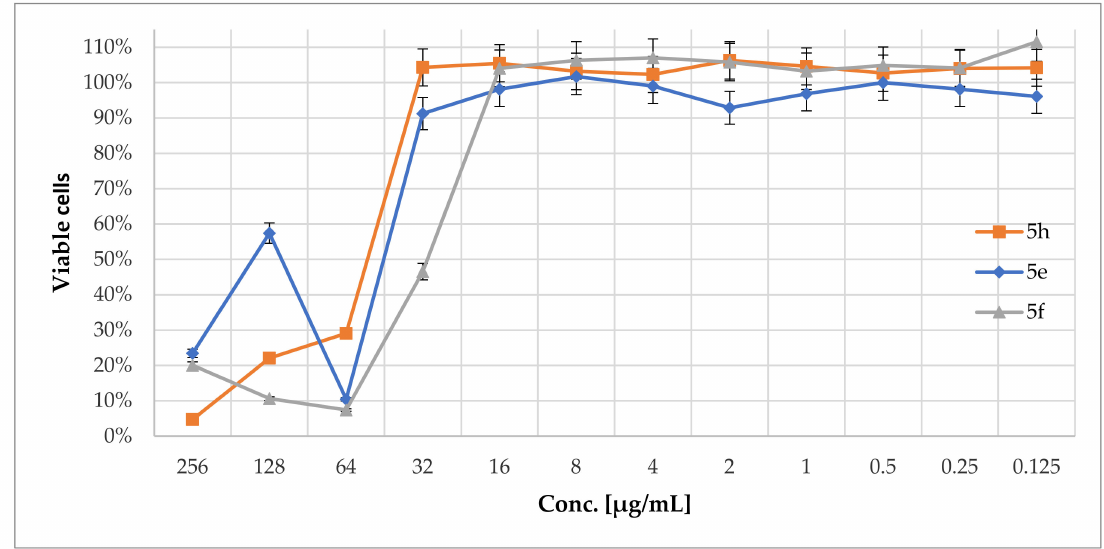
Figure 1. Viability of the Vero cells treated with N -phenacyldibromobenzimidazole derivatives. Legend: Range of conc. of 5e – f and 5h where CC 50 and CC 90 were noted against the Vero cells: CC 50 = 32–64 µ g/mL and CC 90 = 64–256 µ g/mL for 5e – f ; CC 50 = 32–64 µ g/mL and CC 90 = 256 µ g/mL for 5h . Values are presented as means ± standard deviation. Data represent mean ± SD, n =